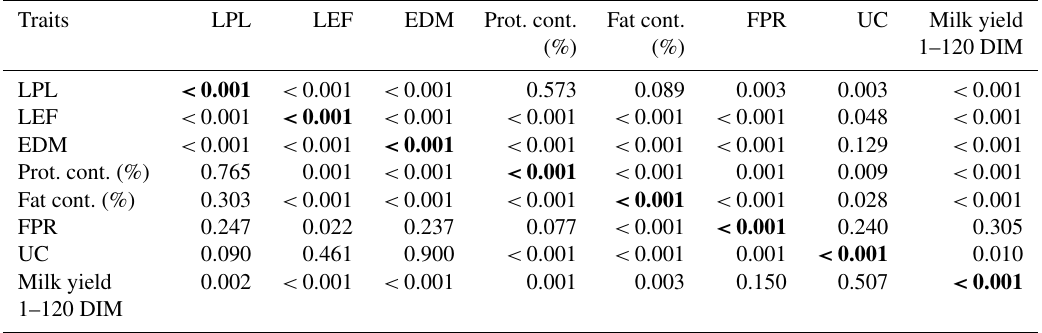
Table 7. P values for heritability and phenotypic and genetic correlations between lifetime productivity traits and milk yield during first